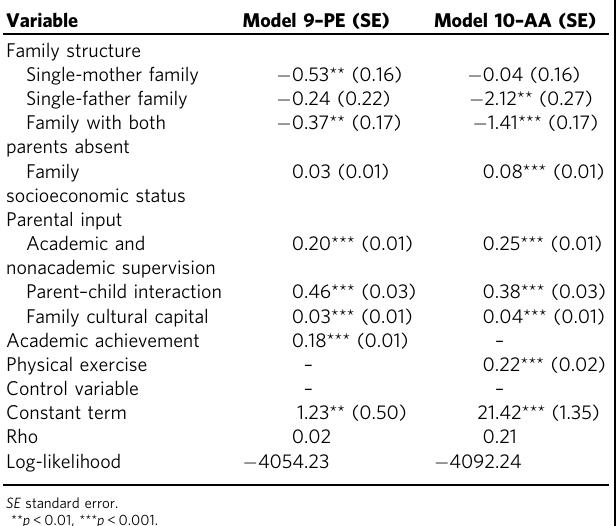
Table 4 Fixed-effect model for estimating students ’ involvement in PE and their AA ( N =